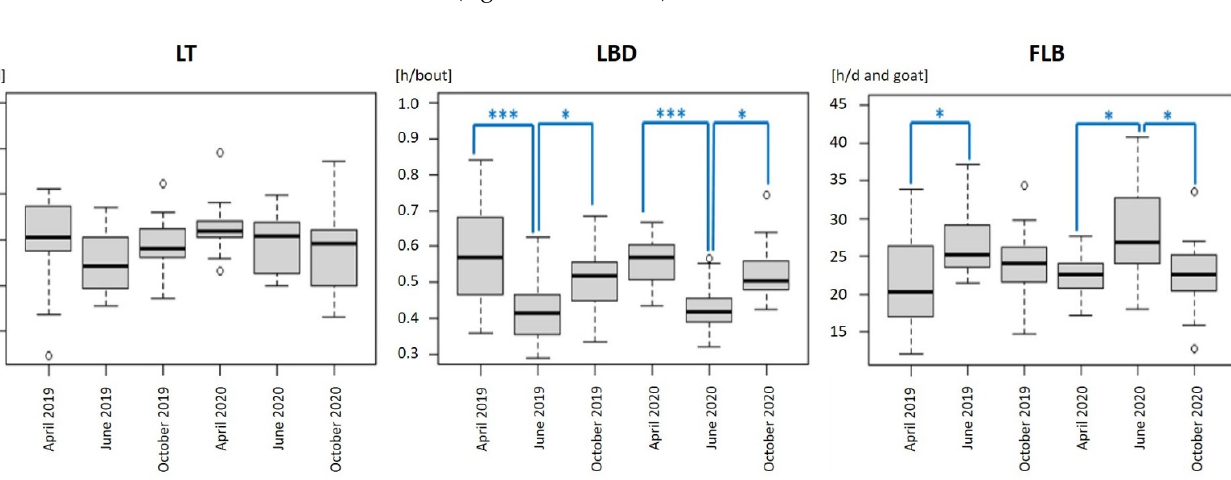
Figure 3. Boxplot diagrams representing the mean duration of lying time (LT), the mean lying bout duration (LBD) and the mean frequency of lying bouts (FLB) for all examined goats. *** representing p ≤ 0.0001; * representing p ≤ 0.05 .